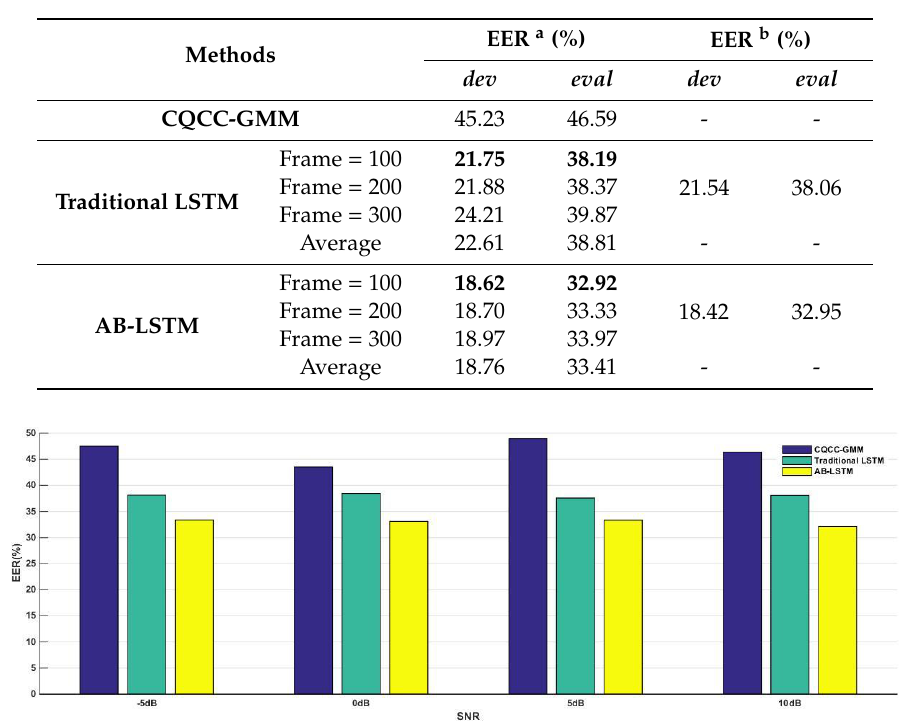
Figure 8. The average EER values of CQCC-GMM, traditional LSTM, and AB-LSTMs at different SNR levels.